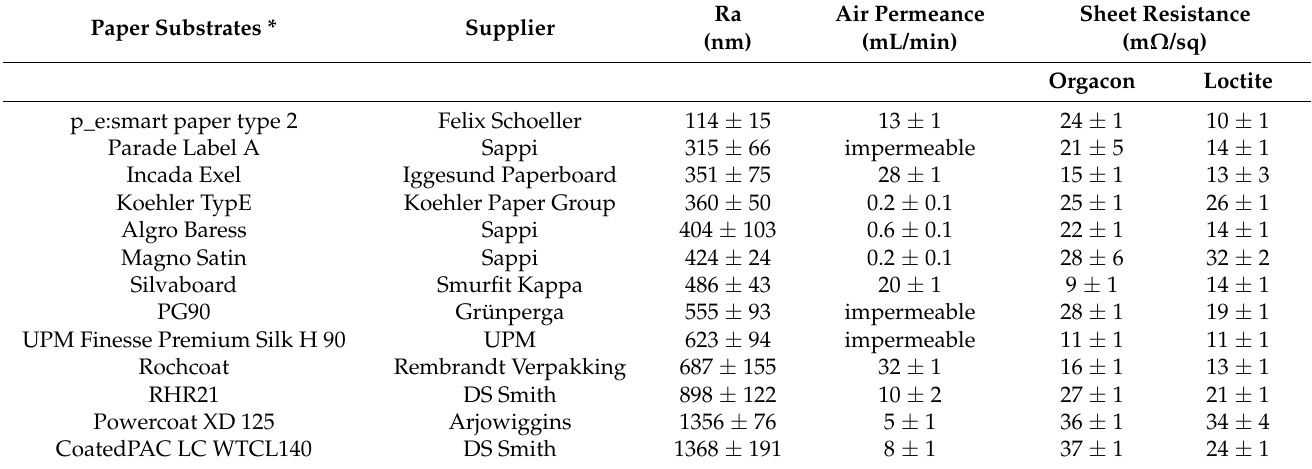
Table 1. Ultimate selection of fiber-based substrates, compatible with printed electronics.